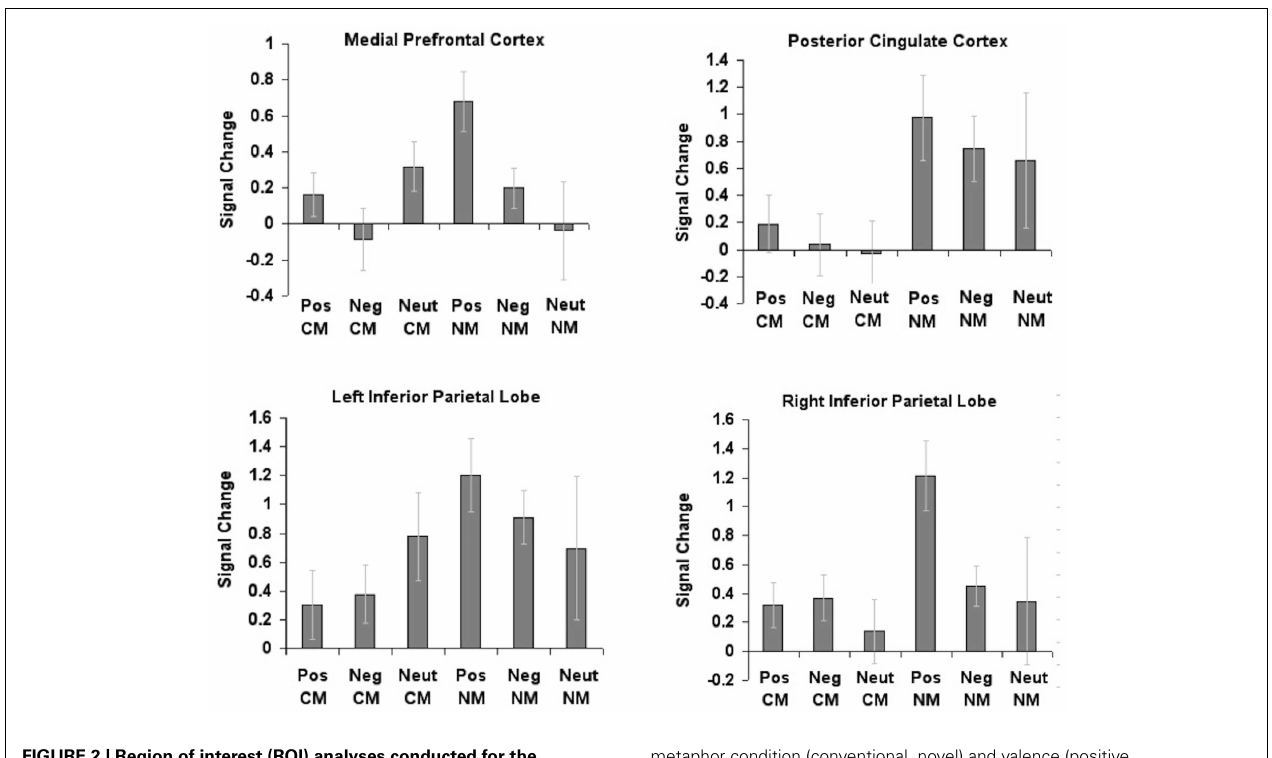
FIGURE 2 | Region of interest (ROI) analyses conducted for the four regions showing repetition enhancement effects from the activation centroids, previously described in Subramaniam et al. (2012) . Mean beta signal extracted within each region for each